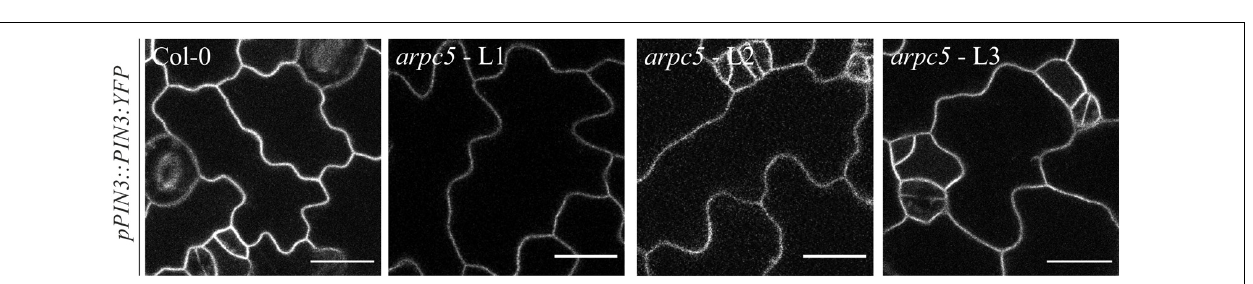
2007; Kleine-Vehn et al., 2008b; Lanza et al., 2012). PIN3